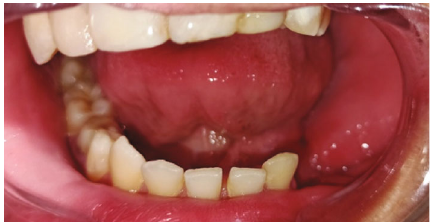
Figure 5: Intraoral view.